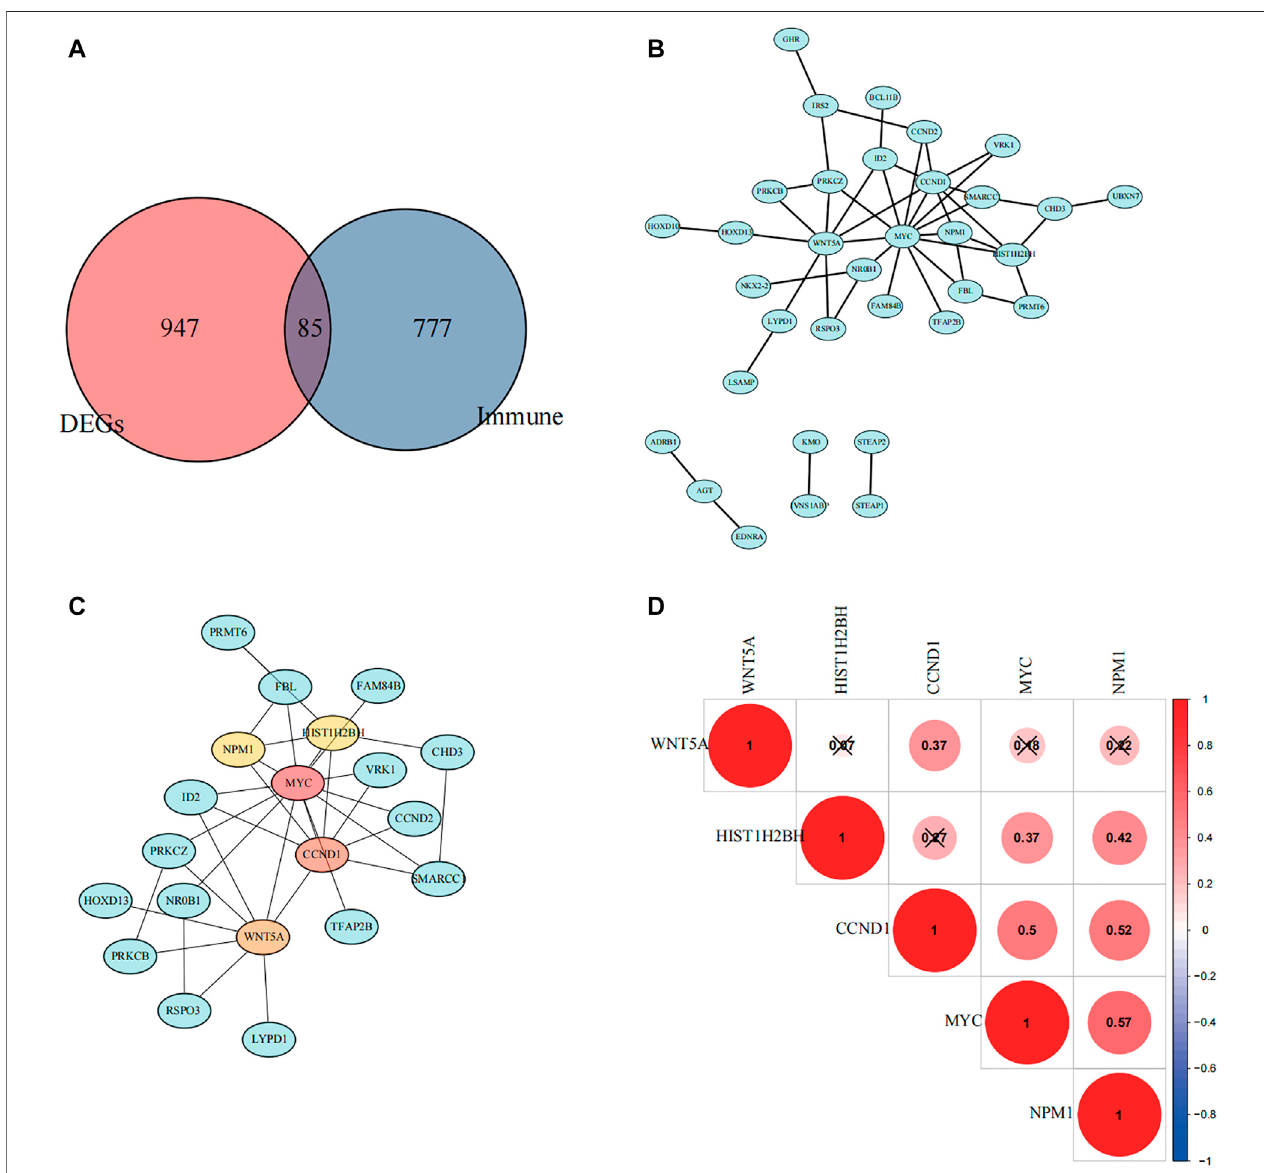
FIGURE 4 | Selection of hub genes. (A) A Venn diagram showing immune-related differential genes. (B) Protein interaction network mapping based on negatively associateddifferentialimmunegenes. (C) Top fi vedifferentialgeneswereobtainedaccordingtotheMatthewscorrelationcoef fi cient(MCC)algorithm. (D) Thecorrelation between the fi ve hub genes was calculated based on the Pearson correlation coef fi cient, and red color indicates positive correlation.